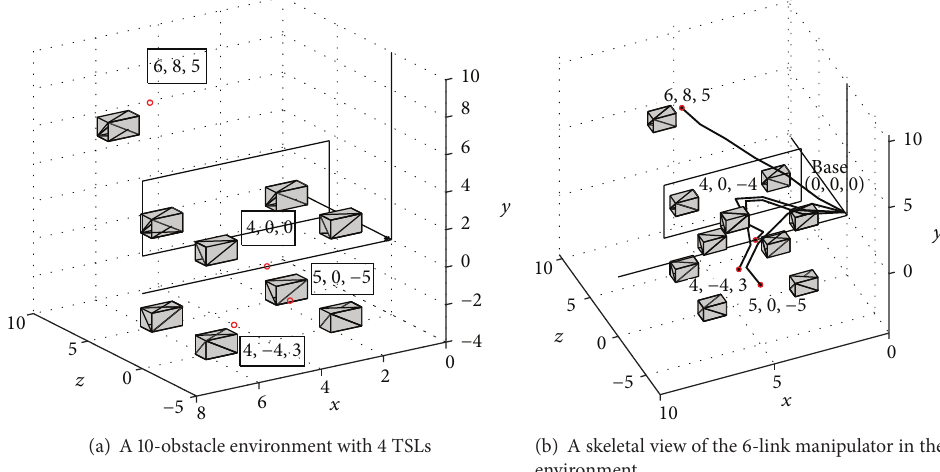
Figure 5: An exemplary case study for strategy validation.